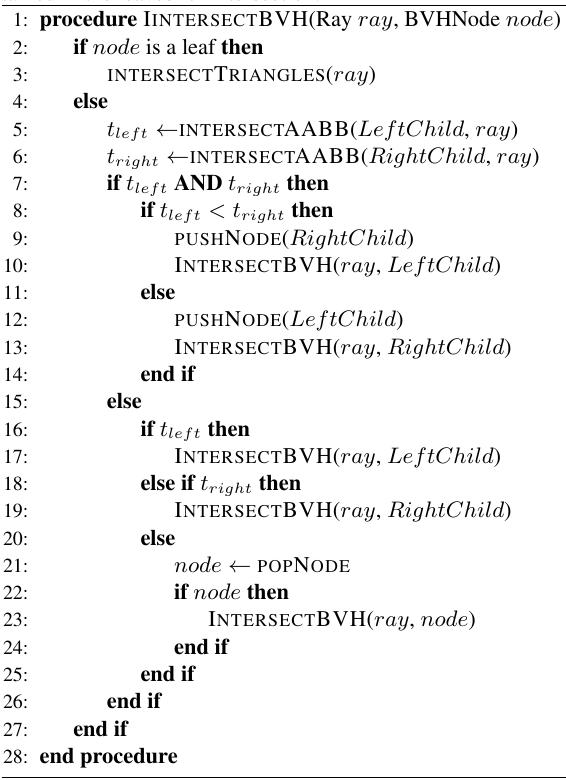
Algorithm 2 Depth-First Traversal of the Bounding Volume Hi- erarchy (BVH). The recursive algorithm traverses the nodes of the BVH in a strict front-to-back order and test the geometry con- tained in the leaves for